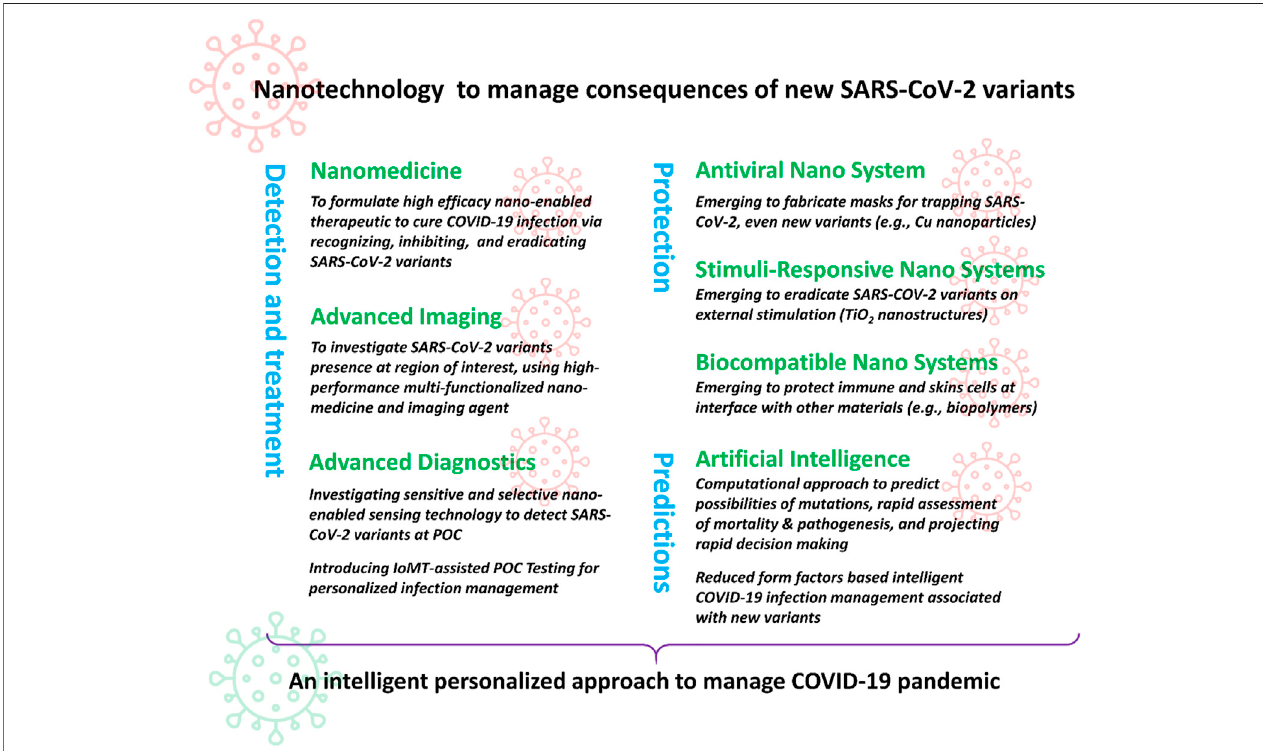
FIGURE2| Projectednano-biotechnology-assistedapproachestomanagethesevereeffectsofCOVID-19infectionpandemic/endemicorbothcausedbynewer SARS-CoV-2 variants.